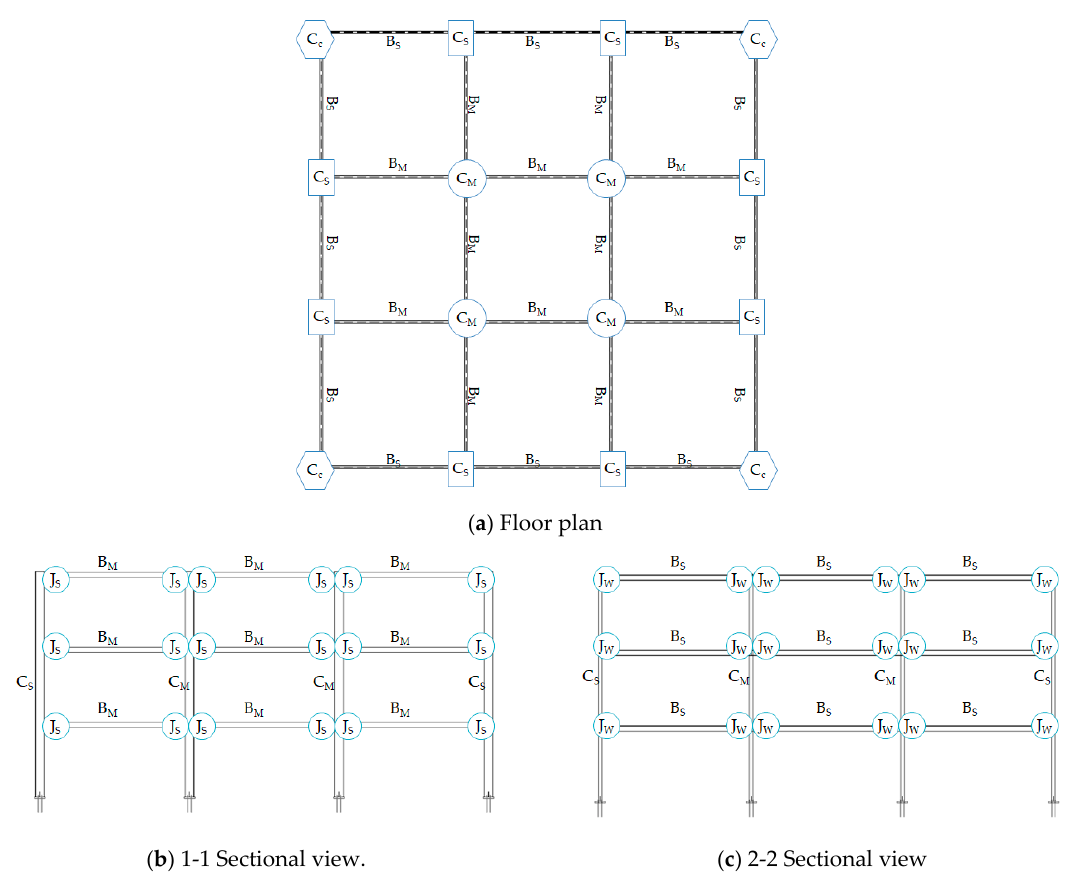
Figure 1. Semi-rigid frame prototype schematic. (B M : Middle beam; B S : Side beam; J S : Strong axis; J W : Weak axis). Table 2. Similarity ratio of each factor.